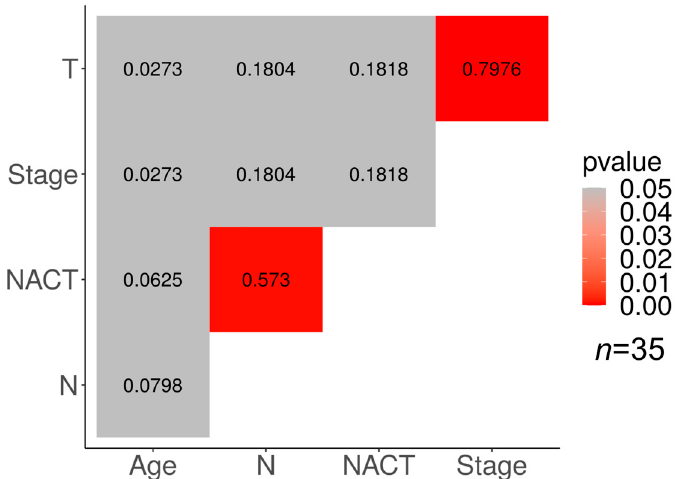
Figure 4. Relationship between clinical characteristics and response to neoadjuvant chemotherapy in luminal B breast cancer. Significant correlations are marked in red ( p < 0.05); numbers show the correlation coefficient.